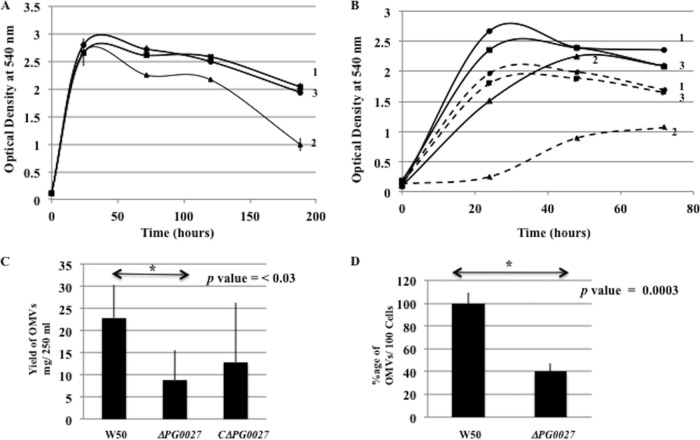
Properties of P. gingivalis W50, the ΔPG0027 mutant strain, and the CΔPG0027 strain. (A) Growth in BHI broth. Samples were withdrawn at different time points, and the OD540 was measured for 8 days. Curves: 1, W50; 2, ΔPG0027 mutant strain; 3, CΔPG0027 strain. (B) Strains were grown in BHI broth as for panel A (solid line) or with the addition of 0.02% Tween 20 (dashed line). Curves: 1, W50; 2, ΔPG0027 mutant strain; 3, CΔPG0027 strain. (C) Histogram showing OMV yields from P. gingivalis W50 and the ΔPG0027 mutant and CΔPG0027 strains. Student's t test yielded a P value of <0.05. (D) Counting of OMVs from TEM experiments. Counts of OMVs present in the ΔPG0027 mutant strain are expressed as a percentage of the OMV counts present in W50 (100%) (P = 0.0003). Strains were grown in an anaerobic cabinet in BHI broth supplemented with hemin.